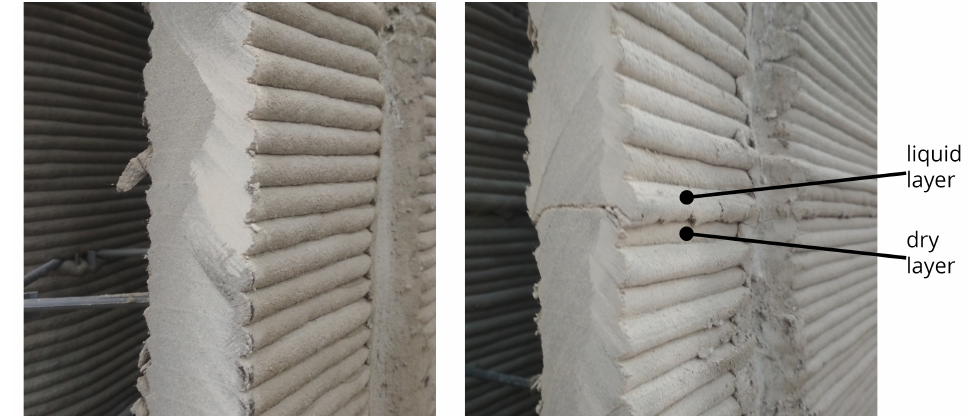
Figure 5. Optimal consistent material (left) and inconsistent material (right).